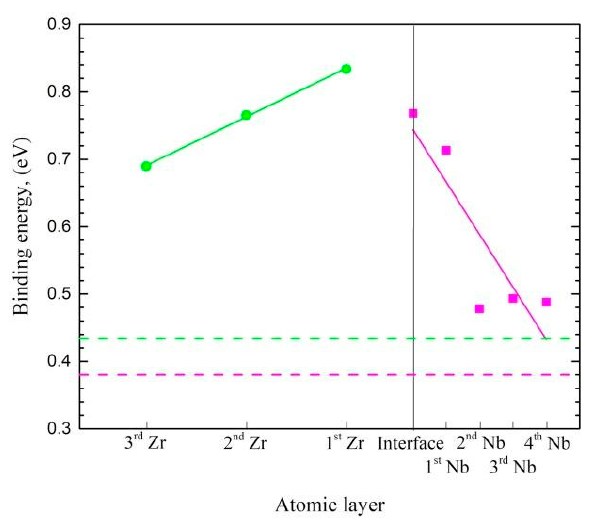
Figure 7. The calculated dependence of the average value of hydrogen binding energy on the atomic layer number. The pink dotted line indicates the hydrogen binding energy in the T sites of the pure Nb, and the green dotted line indicates the average value of hydrogen binding energy in the pure Zr.